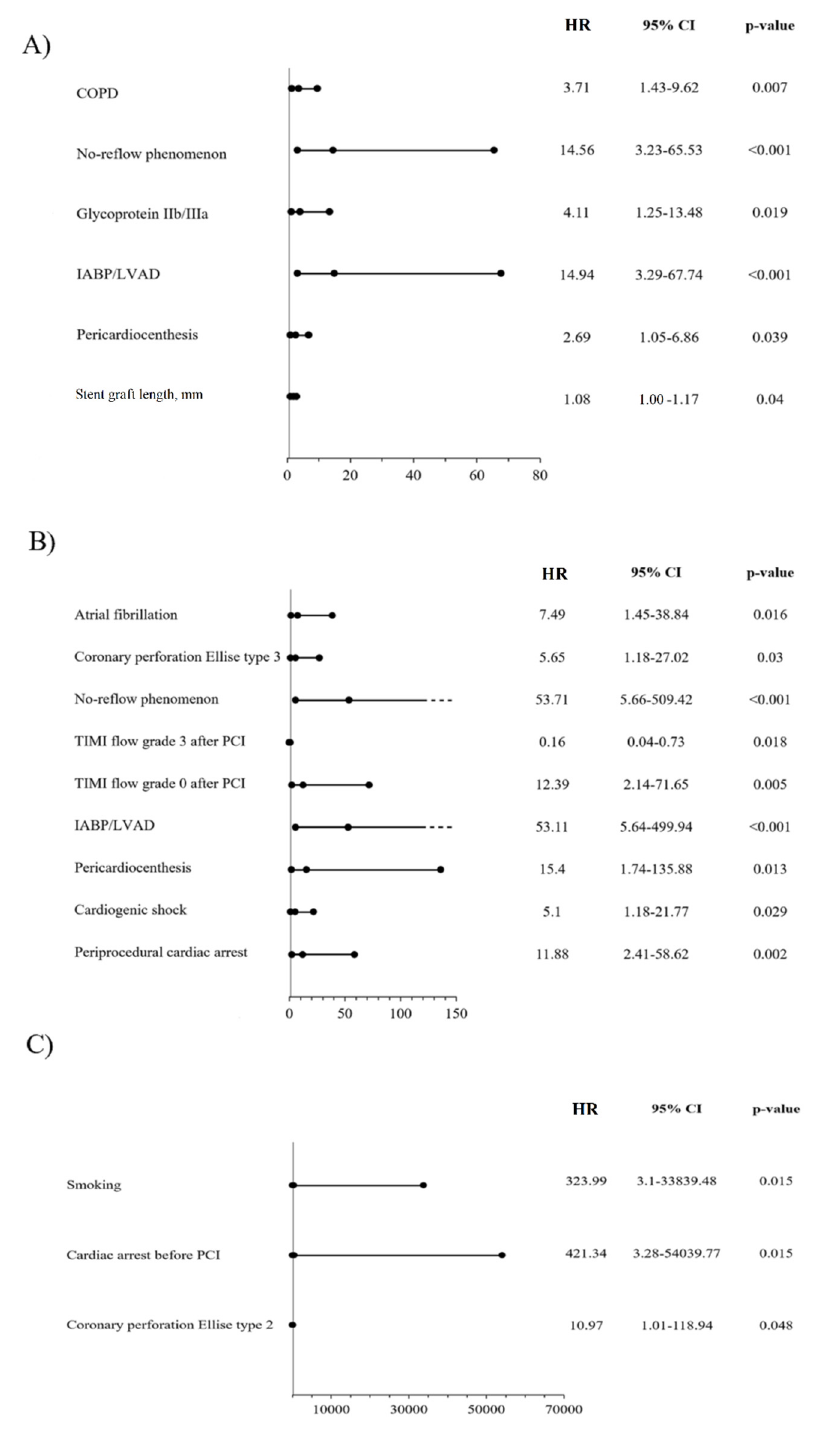
Figure 2. Predictors of selected clinical outcomes assessed by multivariable analysis-models ad- justed for age, sex and BMI; ( A ) major adverse cardiac events (MACE); COPD, chronic obstructive pulmonary disease; IABP, intra-aortic balloon pump counter-pulsation; LVAD, left ventricle assist device. ( B ) Cardiac death; IABP, intra-aortic balloon pump counter-pulsation; LVAD, left ventricle assist device; PCI, percutaneous coronary intervention; TIMI, thrombolysis in myocardial infarction. ( C ) Myocardial infarction; PCI, percutaneous coronary